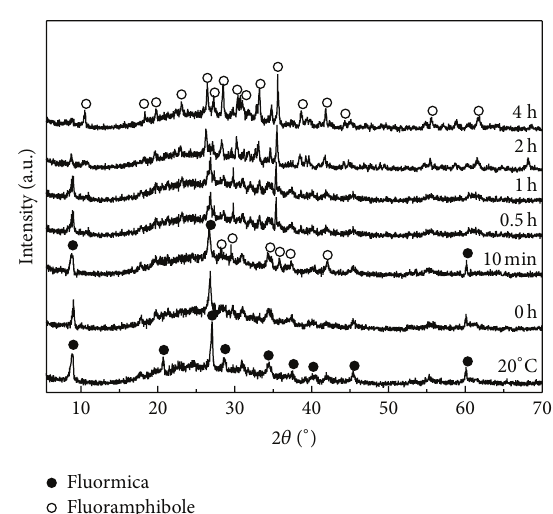
Figure 2: XRD patterns of samples isothermally heated at 820 ∘